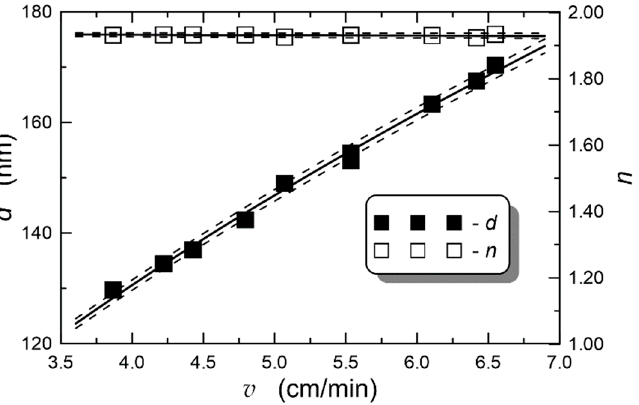
Figure 6. Influence of substrate withdrawal speed from sol on final thickness and refractive index of the composite SiO x :TiO y films. Aging time of sol equal 27 days, annealing at 500 ° C for 1 h. λ = 632.8 nm.